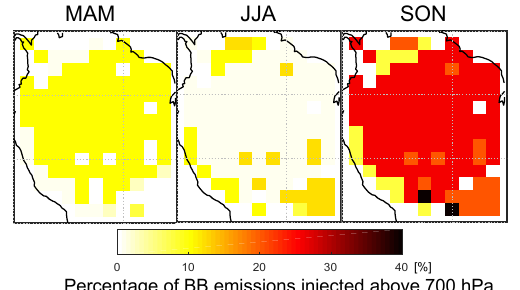
Figure 8. Percentage of total-column biomass burning emissions injected above 700hPa over the Amazon from March to November of 2010 and 2011, based on MISR plume-height analysis.